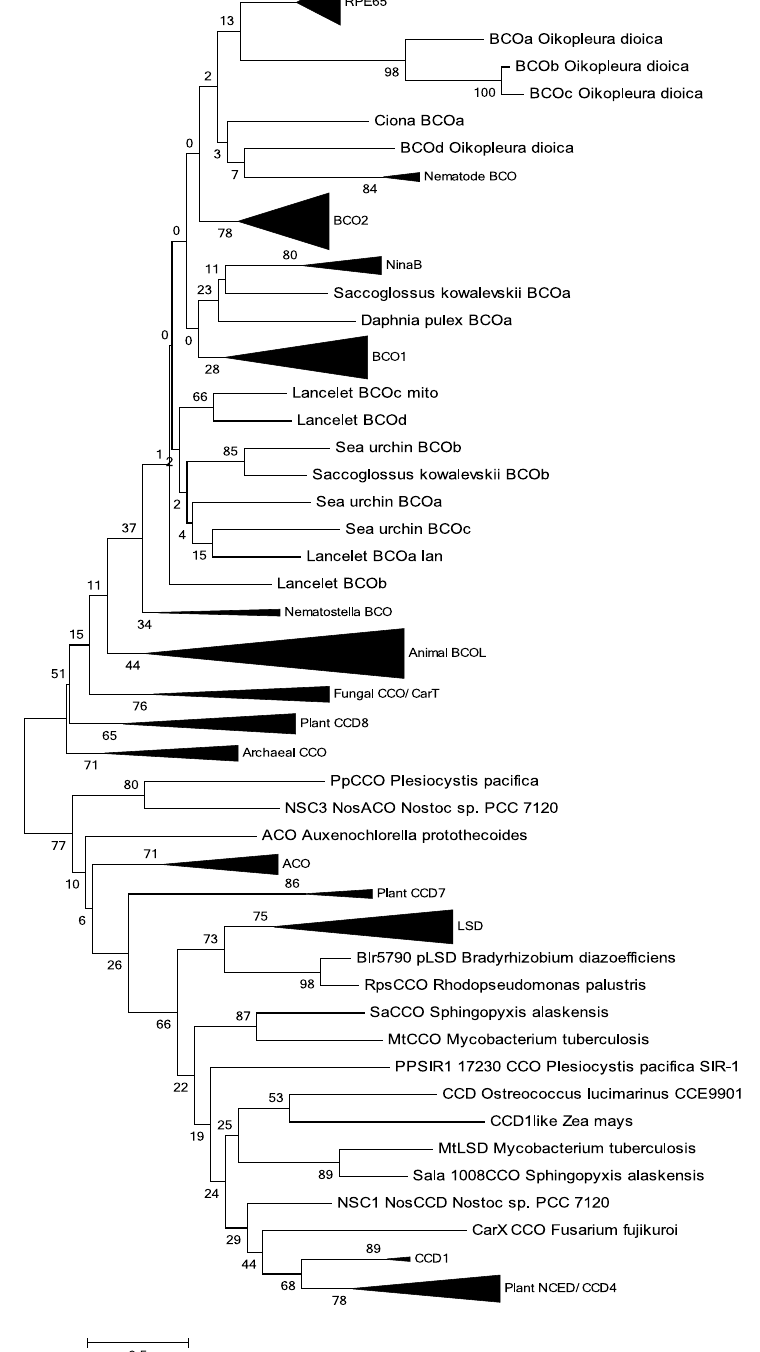
Figure 2. The phylogenetic tree of the carotenoid cleavage oxygenase (CCO) superfamily. The phylogenetic tree was inferred by using the Maximum Likelihood method based on the WAG matrix-based model. The percentage of trees in which the associated taxa clustered together (bootstrep support values) is shown next to the branches. Initial tree(s) for the heuristic search were obtained automatically by applying Neighbor-Join and BioNJ algorithms to a matrix of pairwise distances estimated using the WAG model, and then selecting the topology with superior log likelihood value. A discrete Gamma distribution was used to model evolutionary rate differences among sites (2 categories). The rate variation model allowed for some sites to be evolutionarily